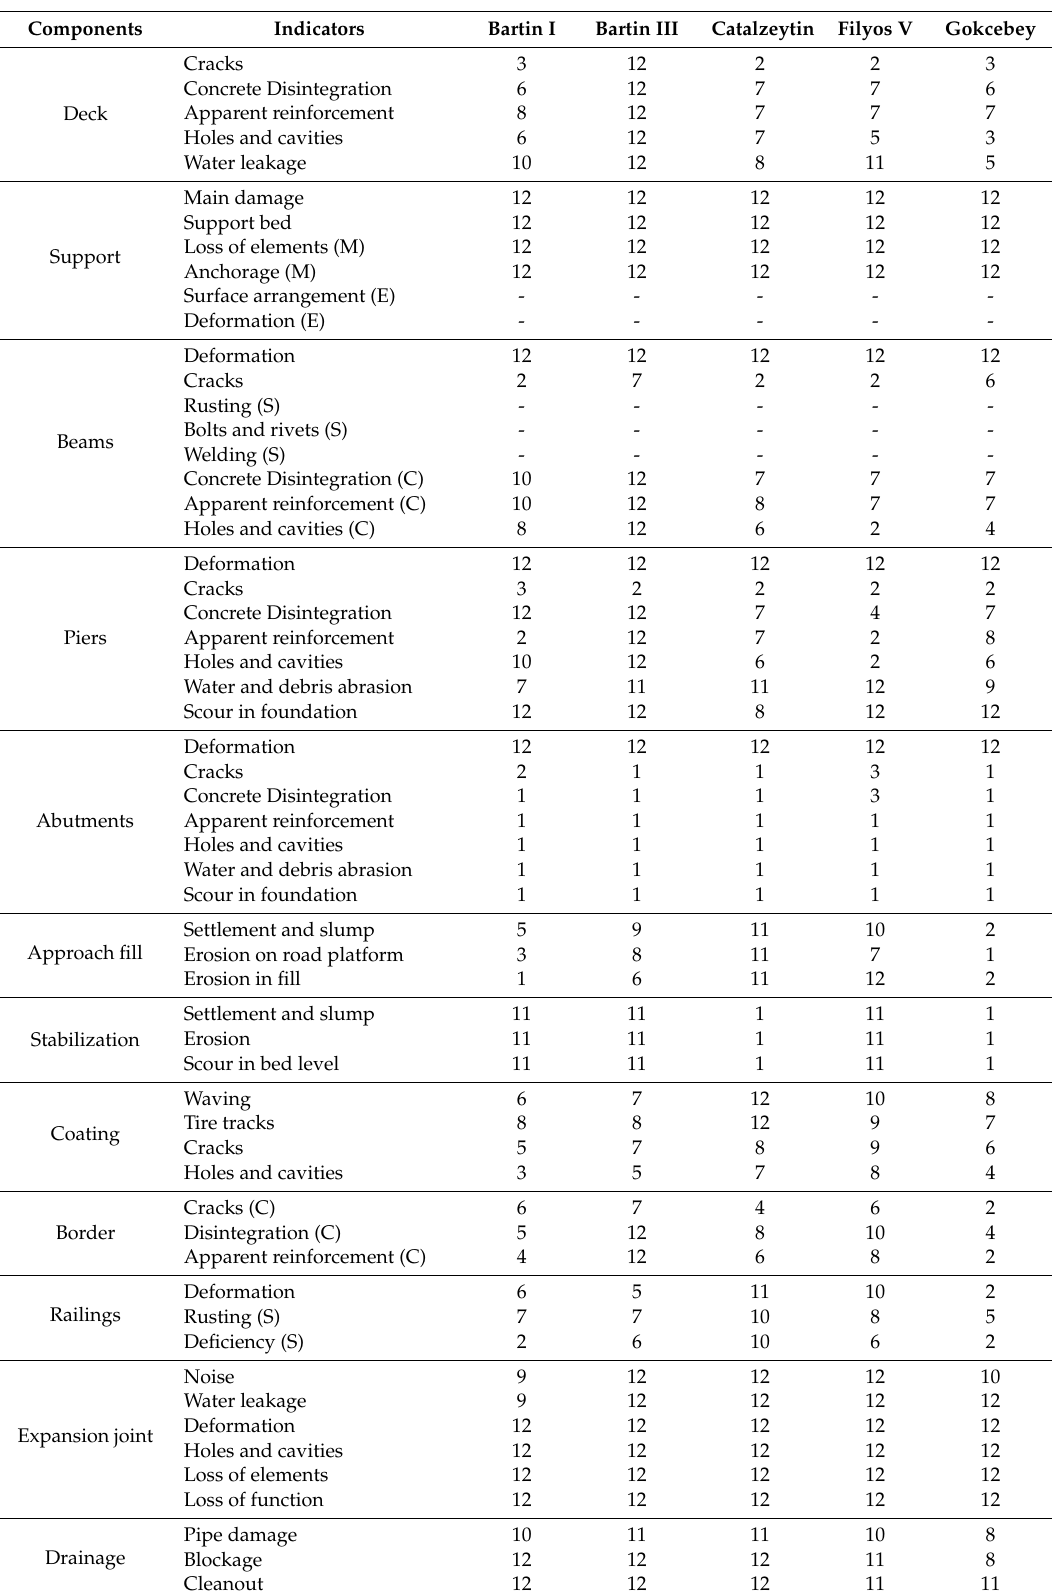
Table 14. Grading of river bridges with regard to structural